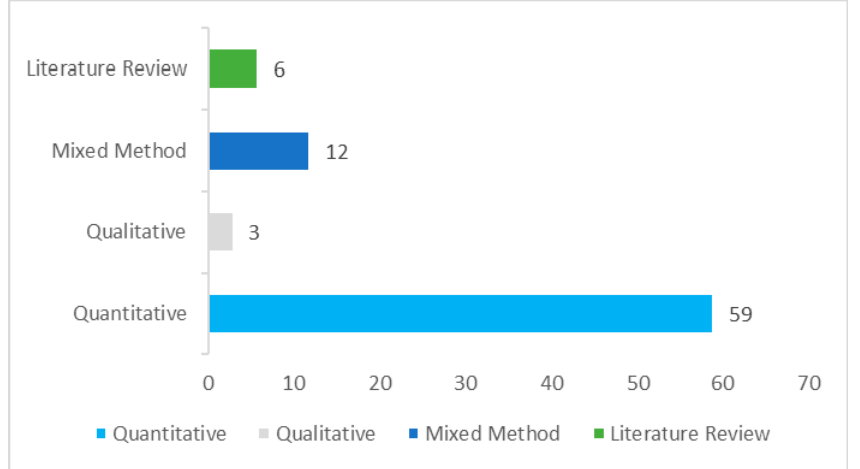
Figure 4. Research methodologies adopted in the sample.